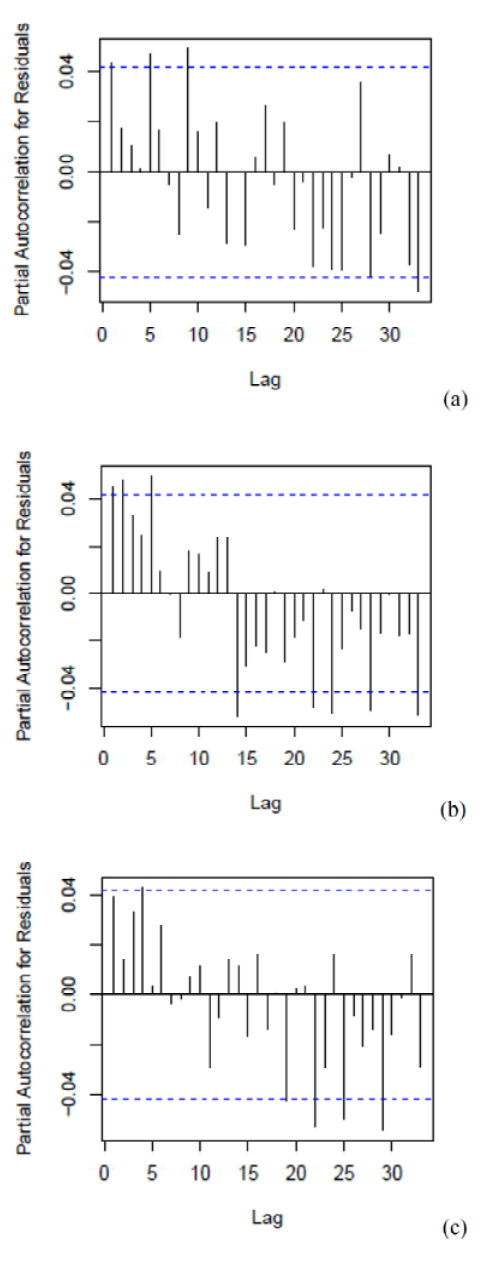
Figure A9. Partial autocorrelation function residuals for the generalised additive Poisson time-series regression models (entire year): 2-day cumulative average of PM CVD ( b ) and CBD ( c ) mortality in Cape Town, South Africa during 2001–2006. Adjusted for the 2-day cumulative average of PM public holidays, day of the week, 2-day cumulative averages of 24-h apparent temperature, wind and rain. K = 30 for time, i.e.